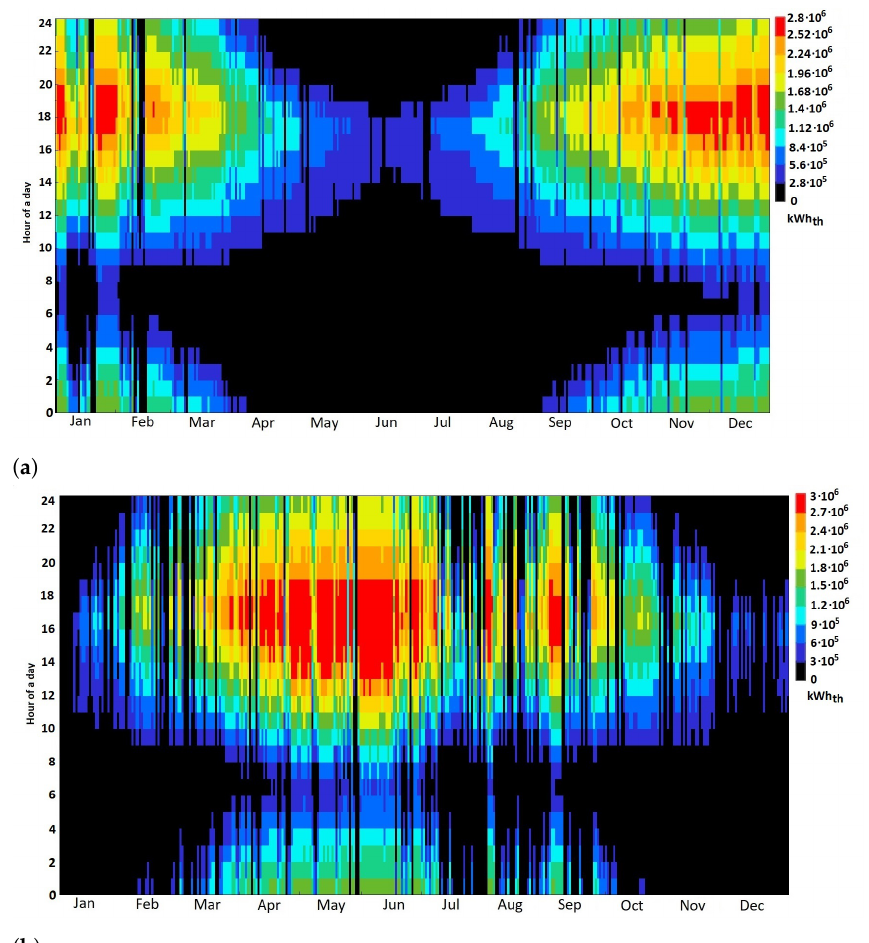
Figure 8. Average monthly time behavior of the surplus energy stored in the thermal energy storage (TES). ( a ) Site 1 case. ( b ) Site 2